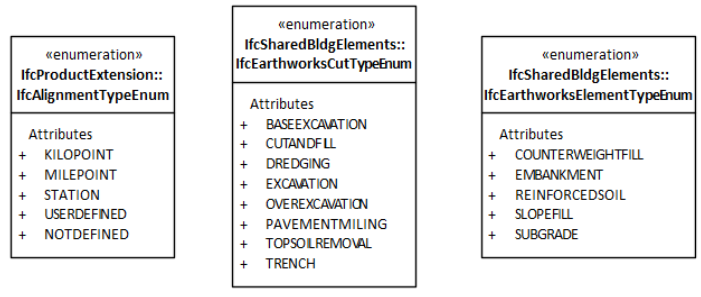
Figure 5. UML class diagram showing IFC aggregation datatypes in UML.